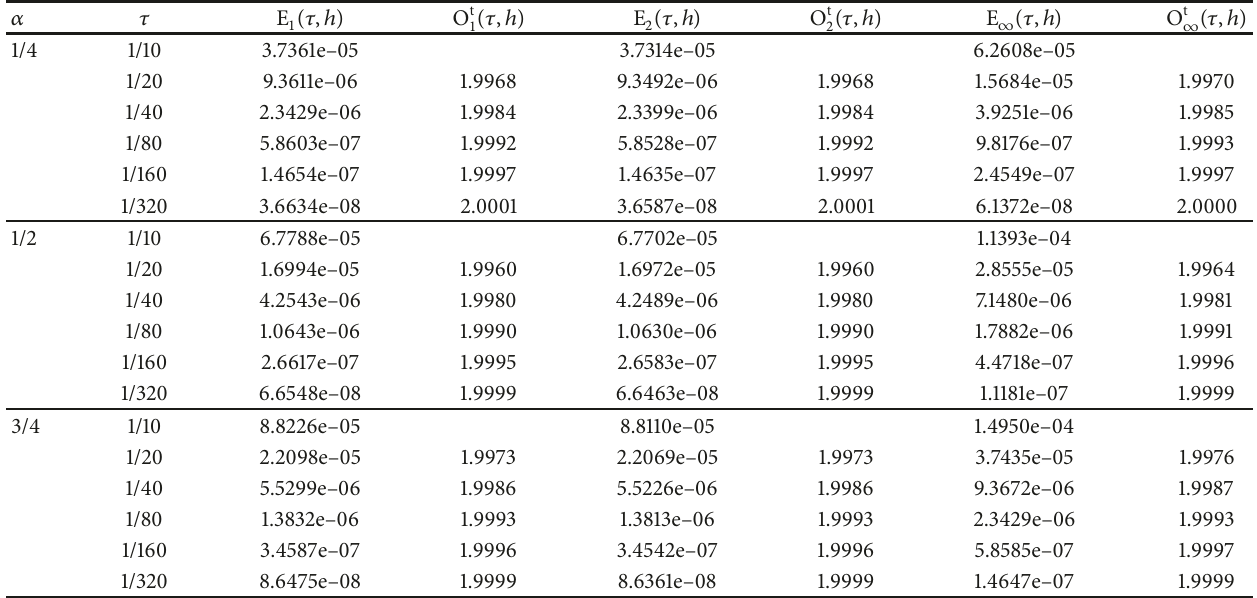
Table 1: The errors and the temporal convergence orders of the compact difference scheme (23) for Example 1 (ℎ = 1/100) .